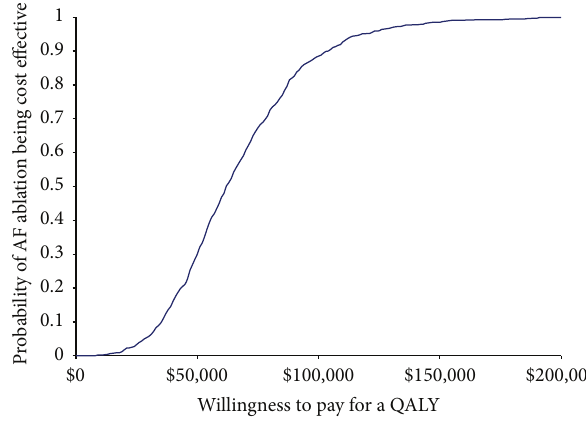
Figure 3: Cost-effectiveness acceptability